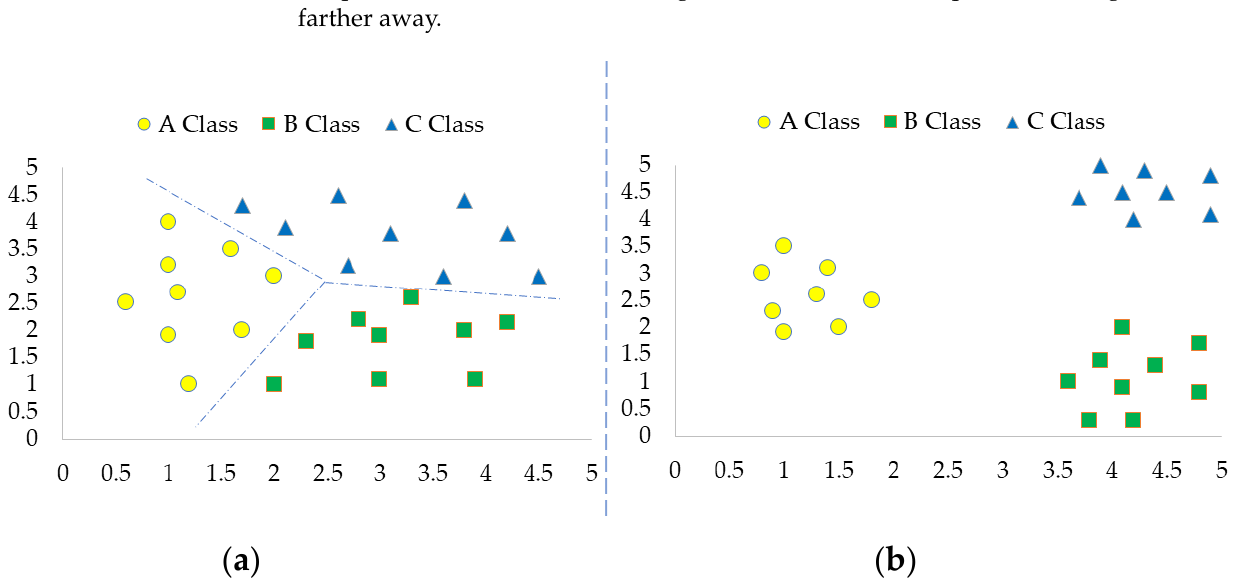
Figure 3. Distinction between classification and metric-learning method in training embedding space. ( a ) The distribution of samples in the embedding space for the classification method. The classification method aims to draw clear decision boundaries between samples of A, B and C classes, so that the samples of different classes may be close together in the embedding space. ( b ) The dis- tribution of samples in the embedding space for the metric-learning method. Deep metric learning brings positive samples closer and pushes negative samples farther apart by decreasing the distance between similar samples and increasing the distance between different classes. Therefore, in the final embedding space, different classes behave as different clusters.